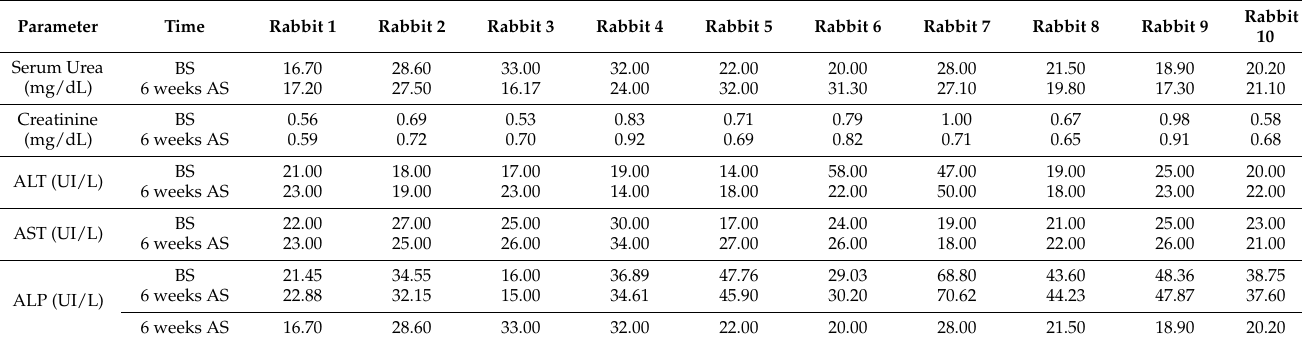
Table 11. The evolution of functional markers.